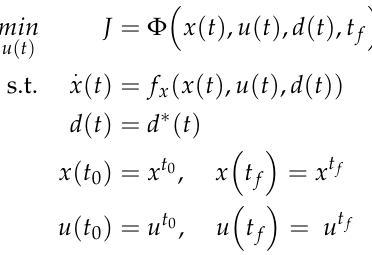
Table 1. The description of each variable in Model 1. Variable Description